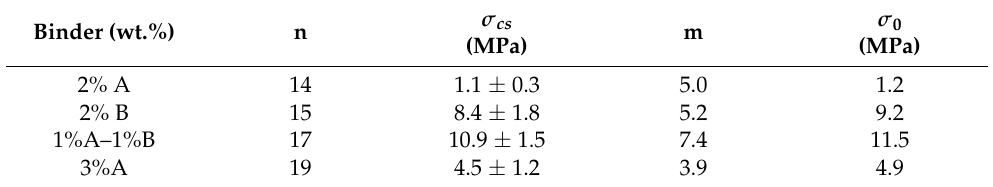
Table 5. Crushing strengths of the alumina foams.